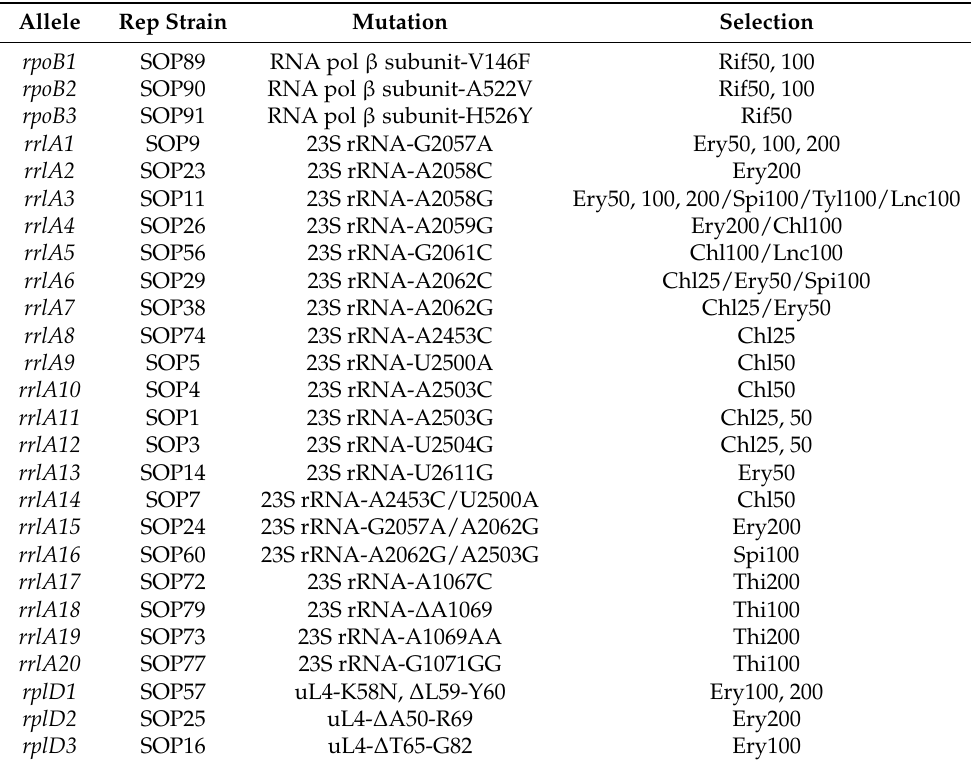
Table 2. Mutations identified in this study. Abbreviations: Rep Strain, representative strain; Chl, chloramphenicol; Ery, erythromycin; Spi, spiramycin; Tyl, tylosin; Lnc, lincomycin; Thi, thiostrepton; Rif, rifampicin. Allele Rep Strain Mutation Selection rpoB1 SOP89 RNA pol β subunit-V146F Rif50, 100 rpoB2 SOP90 RNA pol β subunit-A522V Rif50,